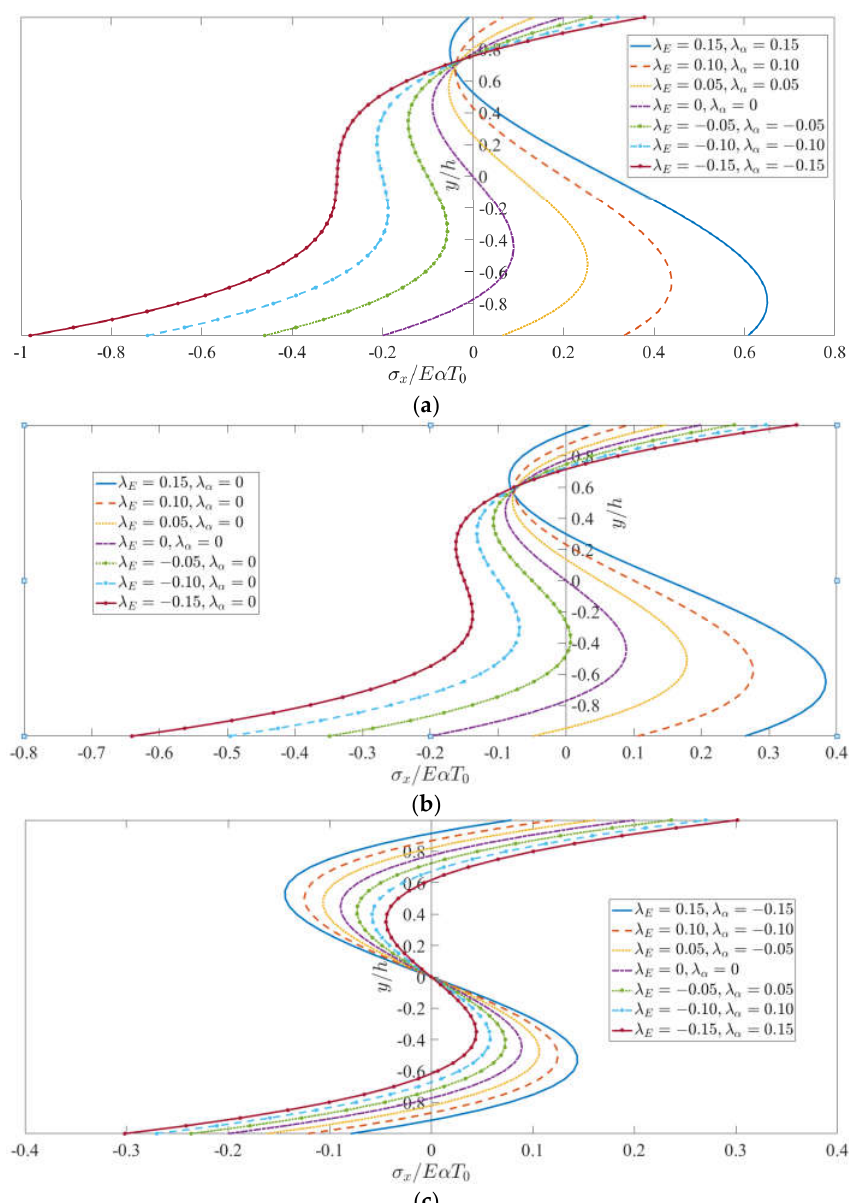
Figure 7. Thermal stresses of Case 3: ( a ) when the variation trend of λ E and λ α is consistent, ( b ) when λ α = 0 and ( c ) when the variation trend of λ E and λ α is the